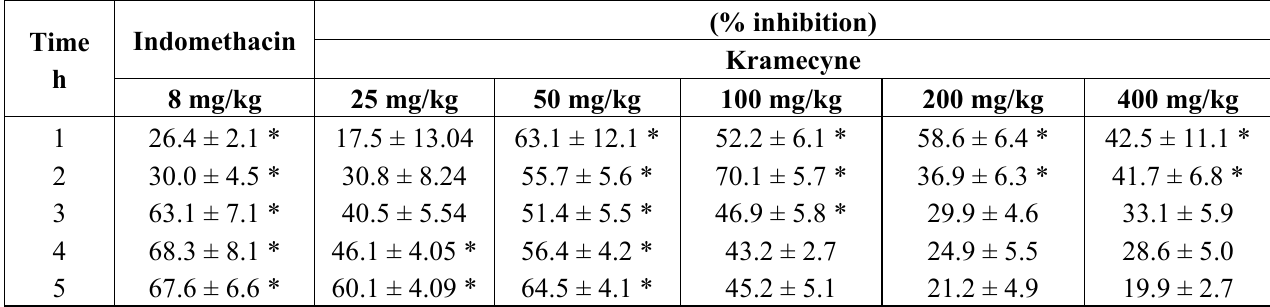
Table 2. Anti-inflammatory activity of kramecyne on carrageenan-induced